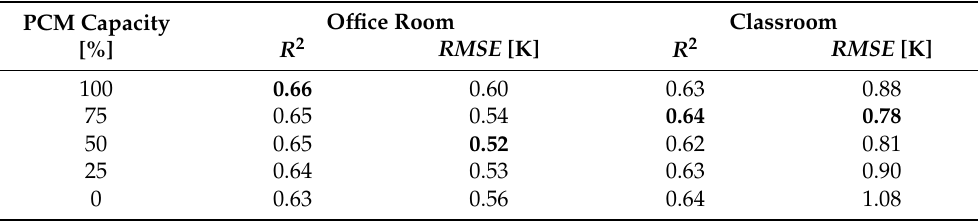
Table 1. Goodness-of-fit measures of the PCM capacity variations for the two case studies. Bold font marks the best-fitting variants.